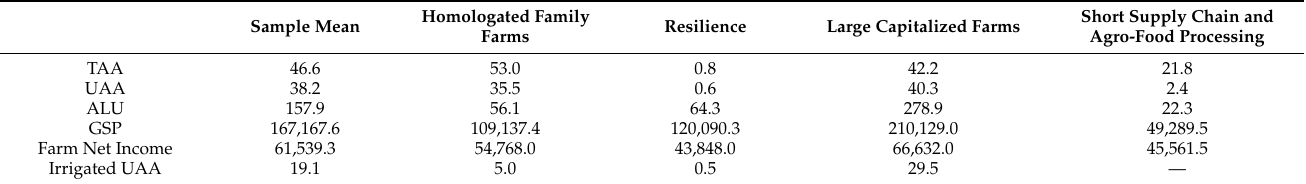
Table A1. Description of the average values of the main structural variables and of the main indexes by cluster identified in the northwest geographical breakdown (2020).